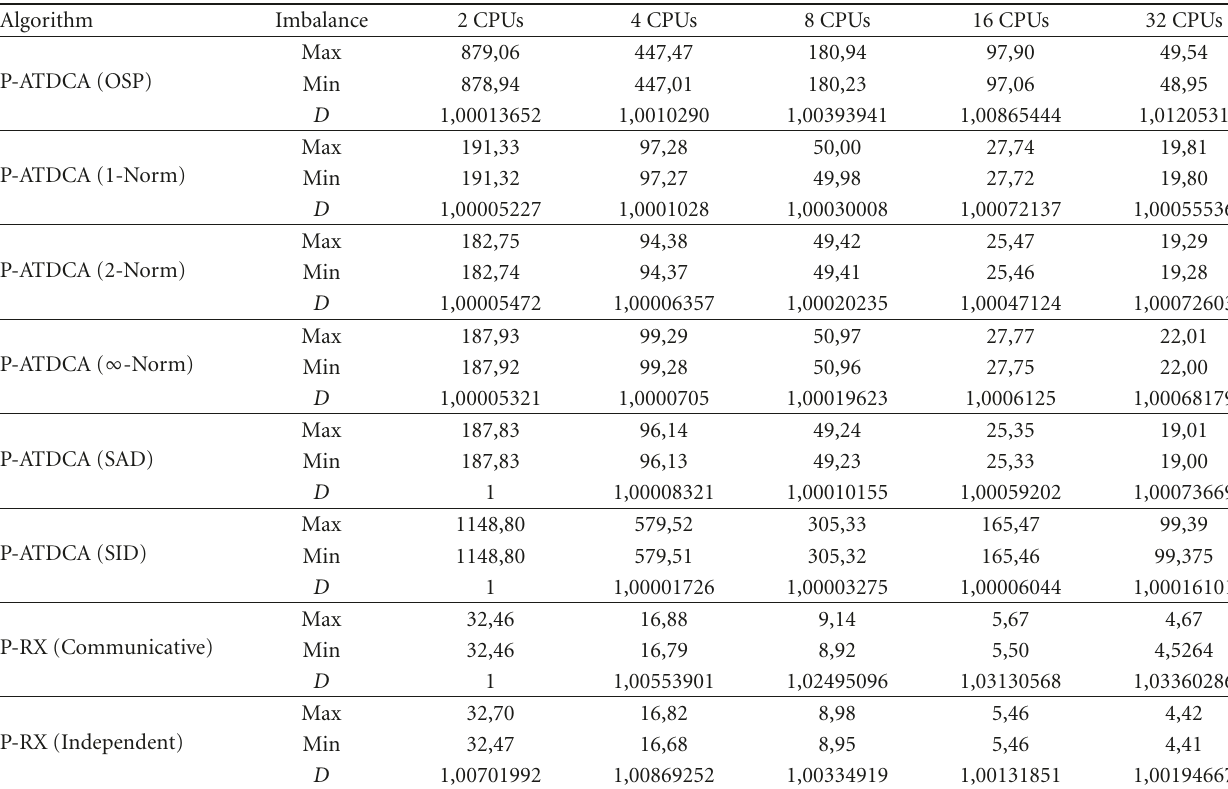
Table 7: Load balancing ratios for the P-ATDCA (implemented using di ff erent distance measures) and P-RX (communicative and independent versions).